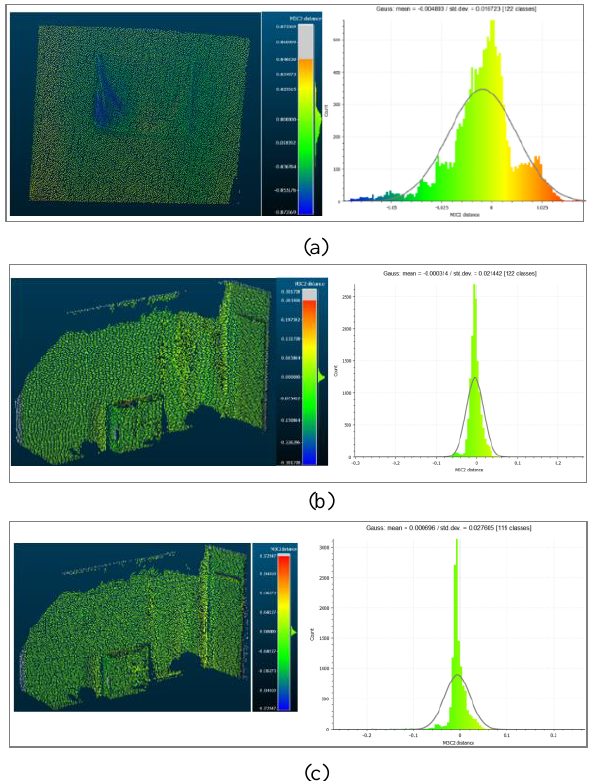
Figure 21. Values and histogram of the relative distances M3C2 [in m] between the clouds from the Kinect Azure and MLS of the scene (a) Room, (b) Corridor without filter, (c) Corridor Figure 19. Superposition of the point clouds of the room scene with filter. The blue represents the smallest distances and the from MLS (in green) and from the red represents the largest Kinect Azure (in red).